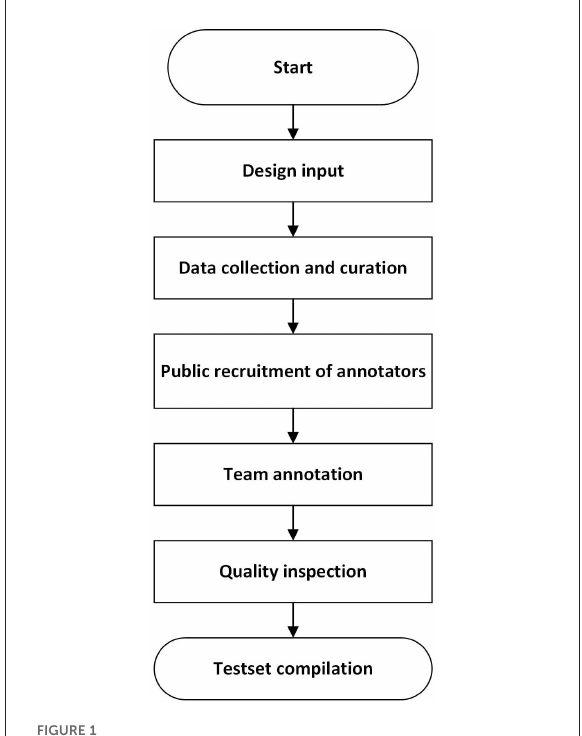
FIGURE1 The workflow to build a test set for pulmonary